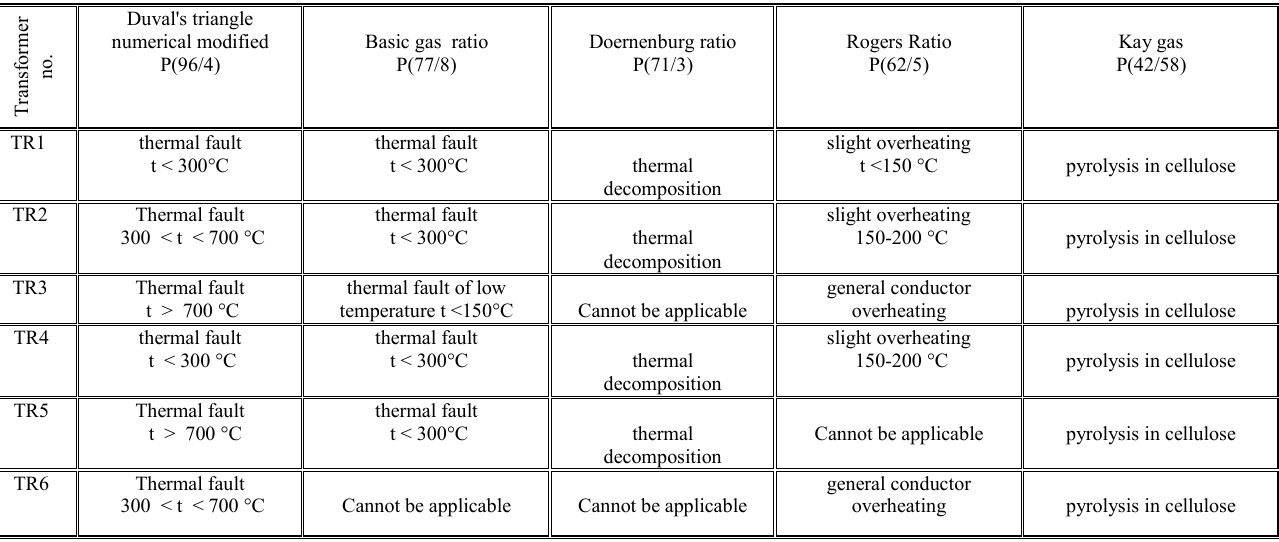
TABLE V. APPLICATION OF THE FAULT DIAGNOSED BY VARIOUS